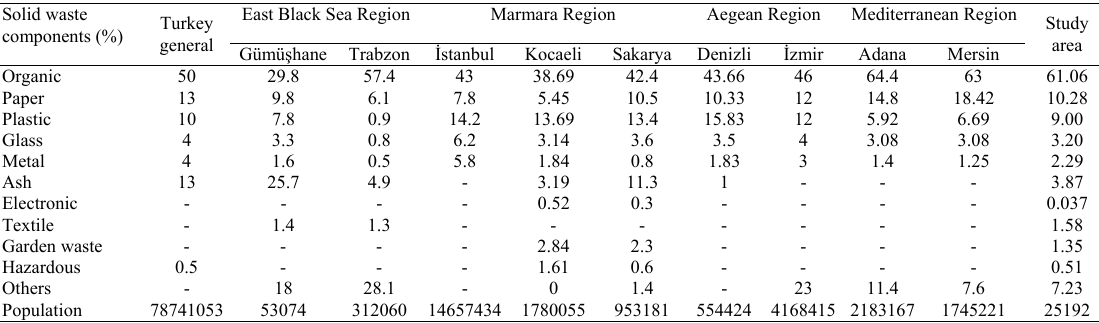
Table 4: The waste percentages of the field of study and the comparison of those percentages with some countries in Turkey (Nas and Bayram, 2008; Aǧdaǧ, 2009; Erses Yay, 2015; Yenice et al., 2011; Öztürk et al., 2015) Solid waste components (%)